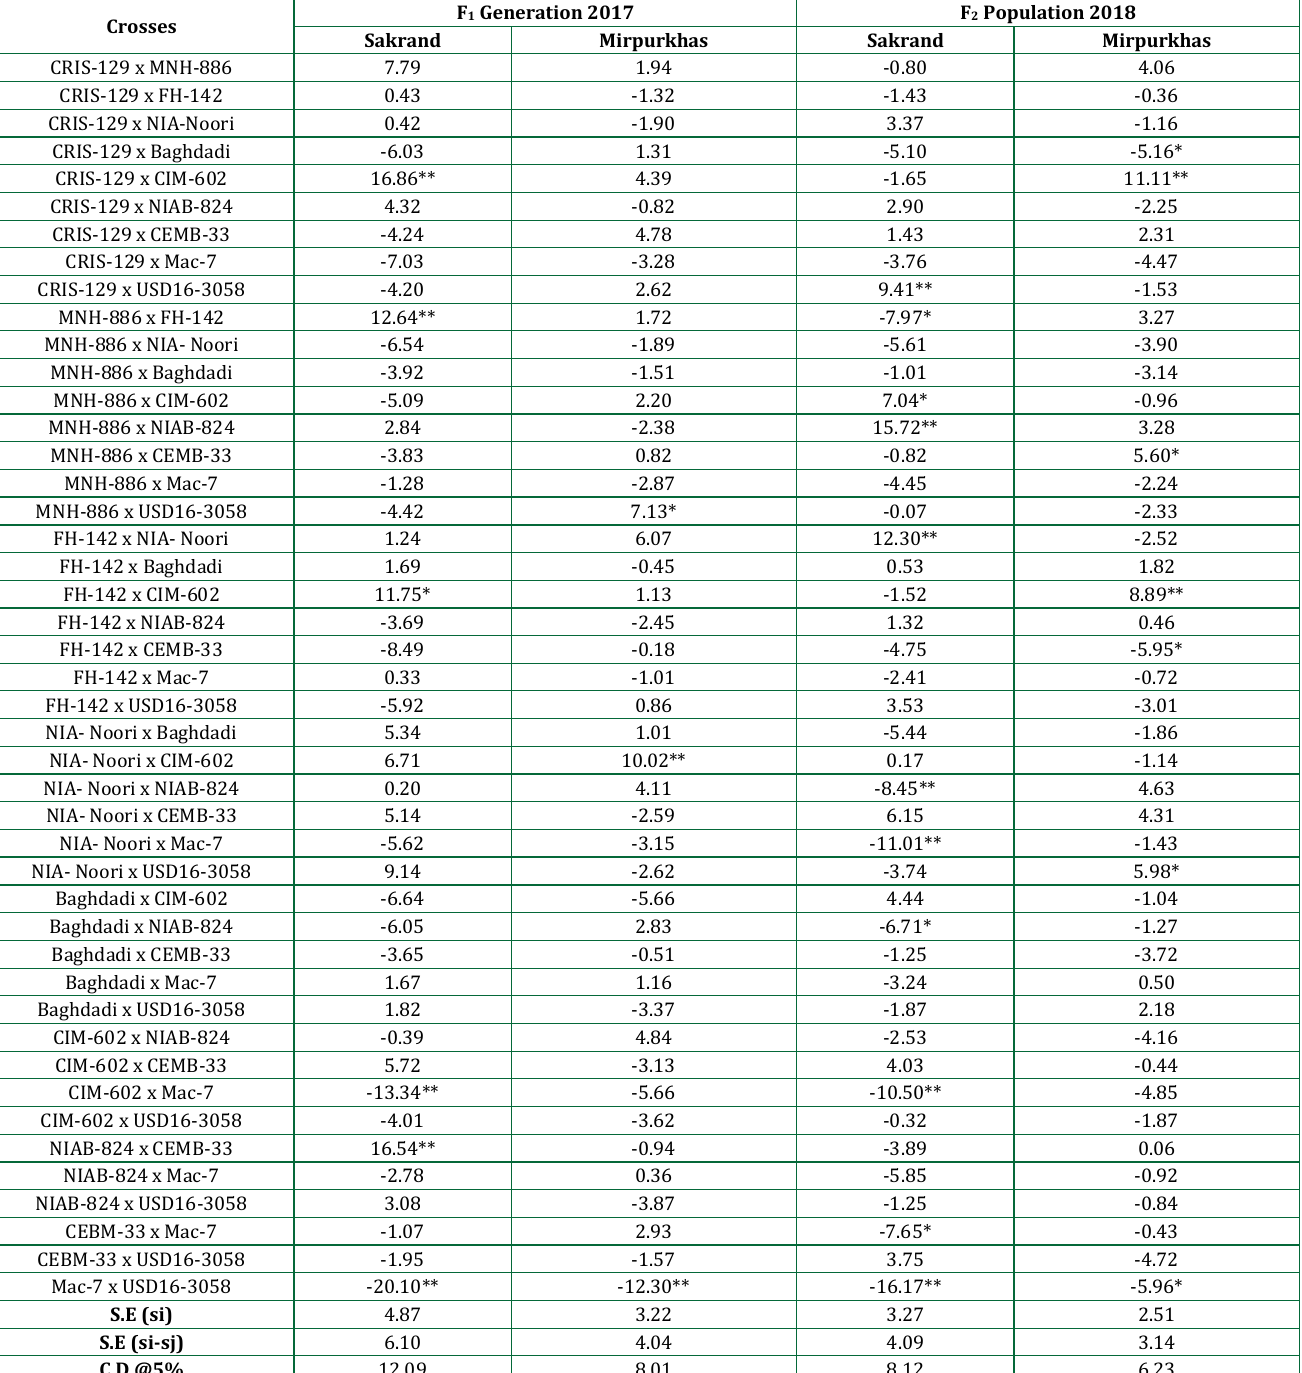
Table 4: Specific Combining Ability (SCA) Effects For Cotton Leaf Curl Virus Disease Incidence %.